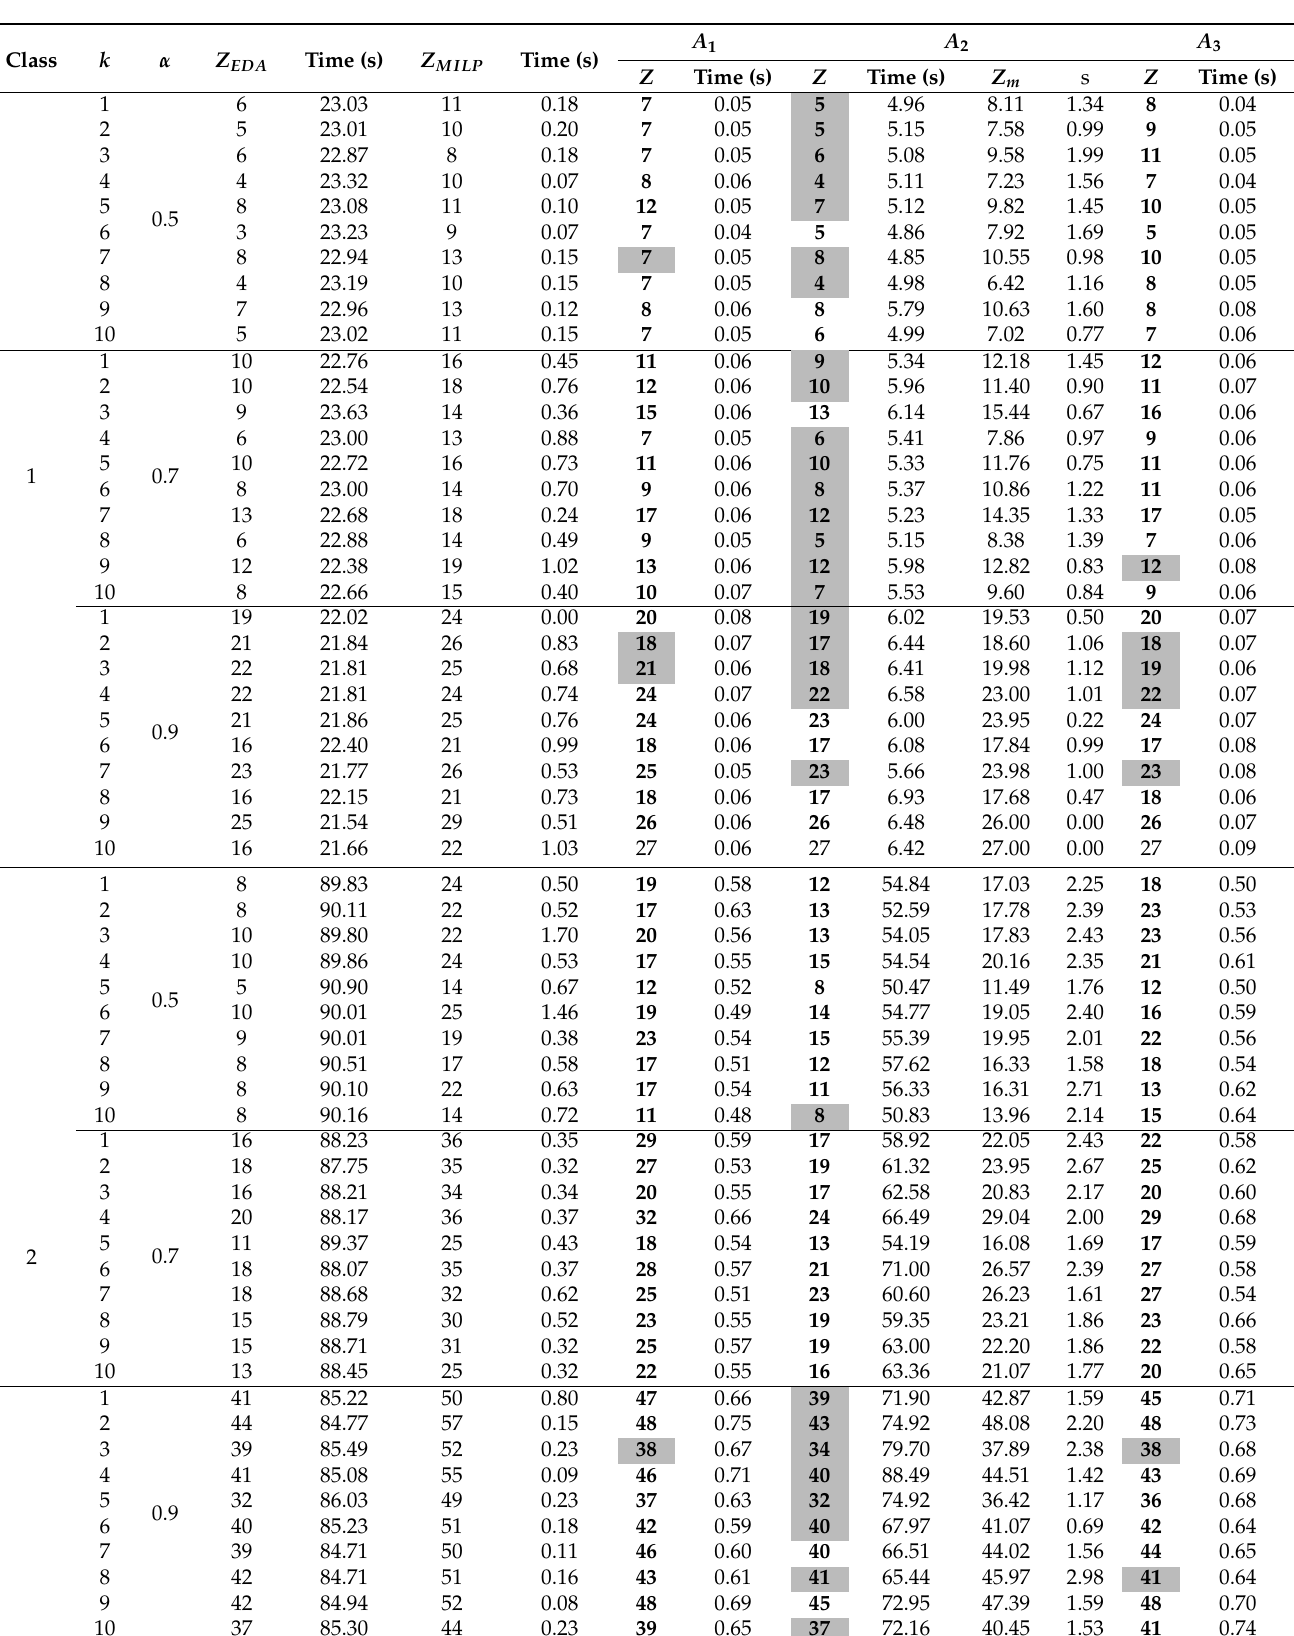
Table 3. Results of class 1 and class 2